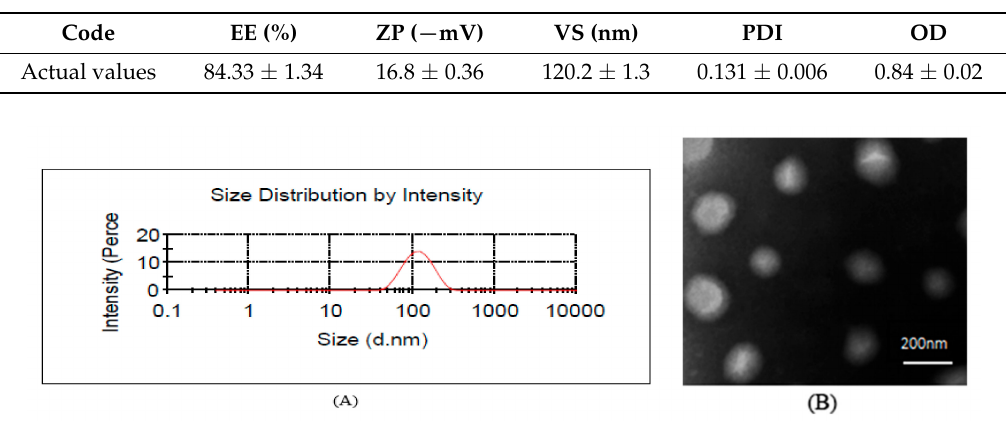
Table 4. Characterization of PAE ethosomes (mean ± SD, n = 3).